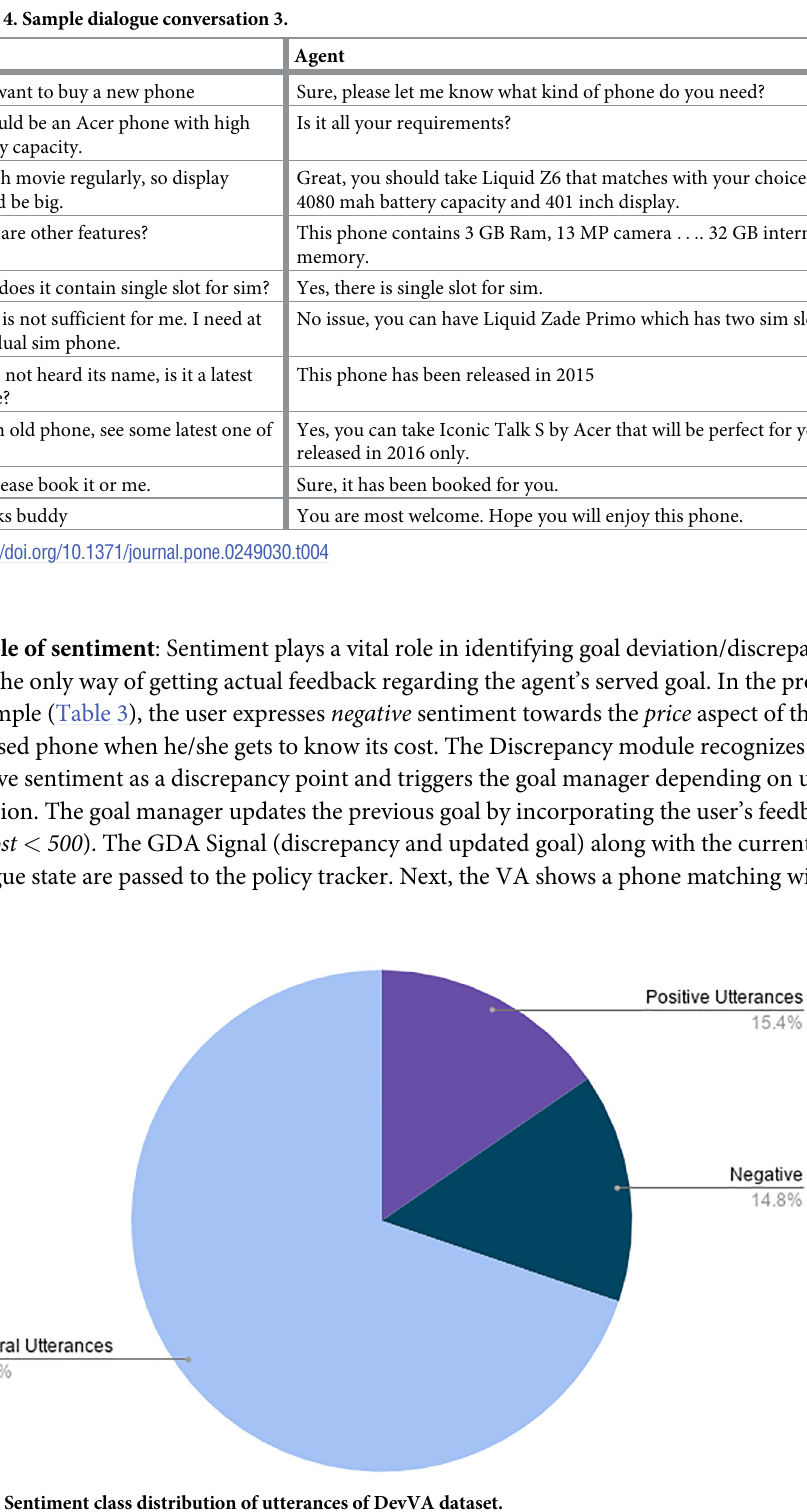
Fig 3. Sentiment class distribution of utterances of DevVA dataset.